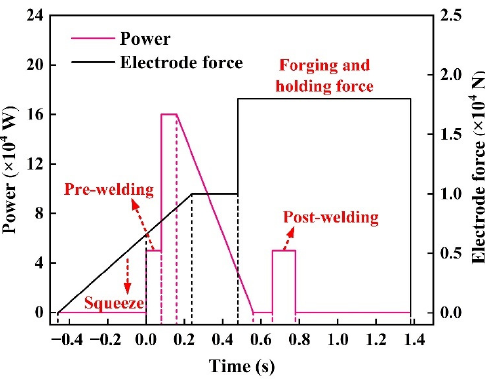
Figure 2. The experimental process parameter